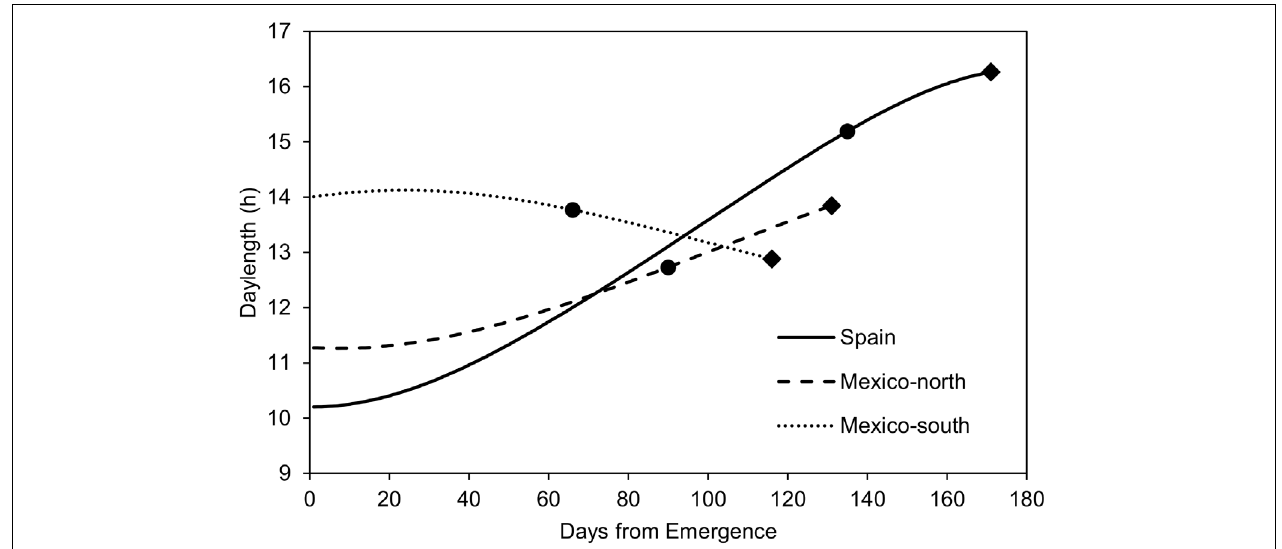
FIGURE 1 | Mean daylength (average of 5 years) during the crop cycles observed at the three testing sites, and mean duration of the emergence-flowering and flowering-maturity phases at each site. Dots: flowering time; Diamonds: maturity